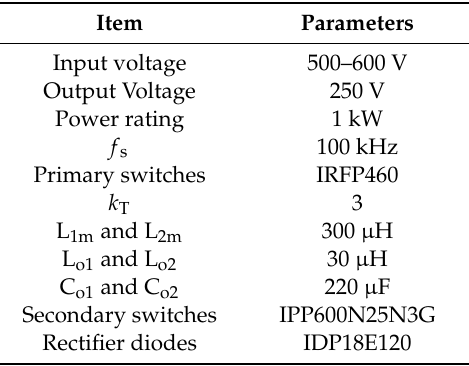
Table 9. Parameters of the prototype.